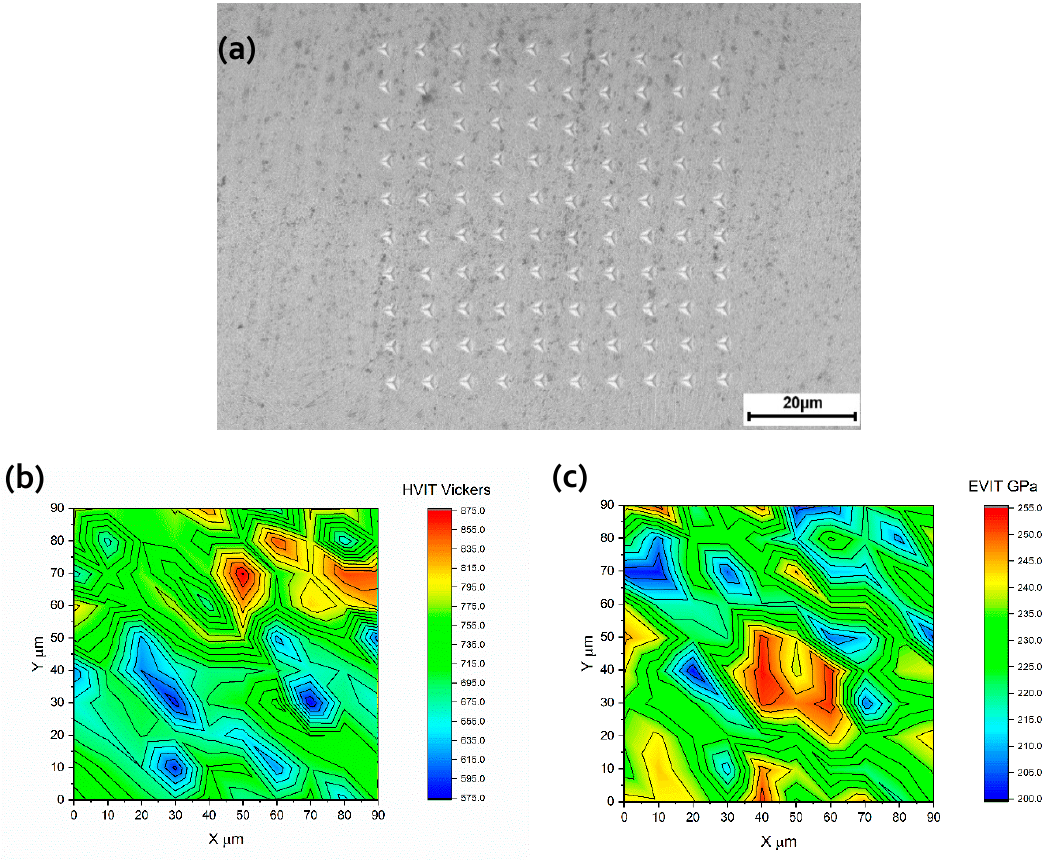
Figure 16. Mechanical properties of the PC9 sample along the build direction: ( a ) Indention array; ( b ) distribution of nano-hardness; and ( c ) Young’s modulus distribution.